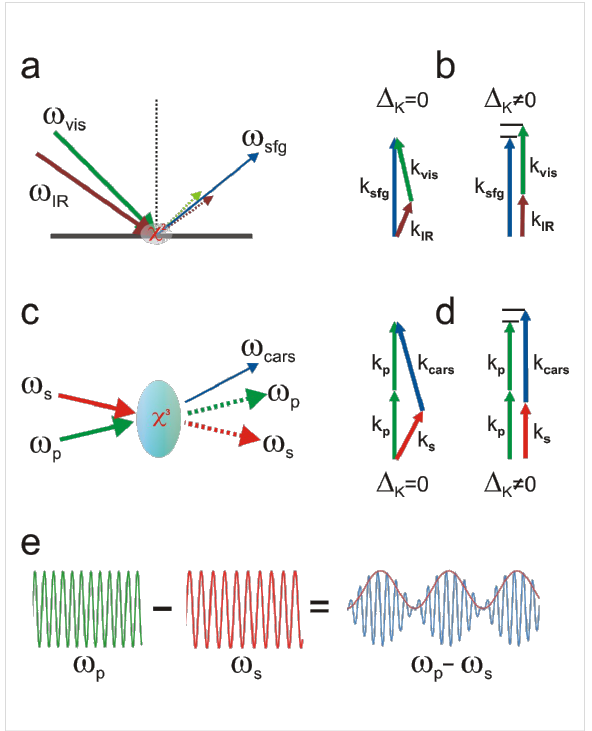
Figure 2: (a) Schematic representation of SFG spectroscopy in a reflection configuration on a surface. (b) The momentum conservation promotes the collinear geometry to fulfil the phase-matching condition (this condition is however relaxed for interfacial SFG). (c) Schematic representation of CARS spectroscopy performed in the bulk phase. (d) The momentum conservation requires the non-collinear geometry to be adopted to fulfil the phase-matching condition. (e) Generation of a beat frequency between the pump and the Stokes